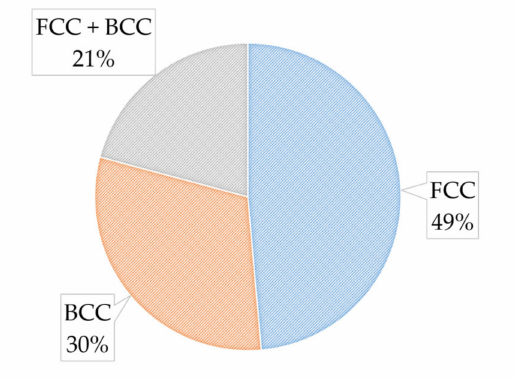
Figure 3. High-entropy alloy major phase